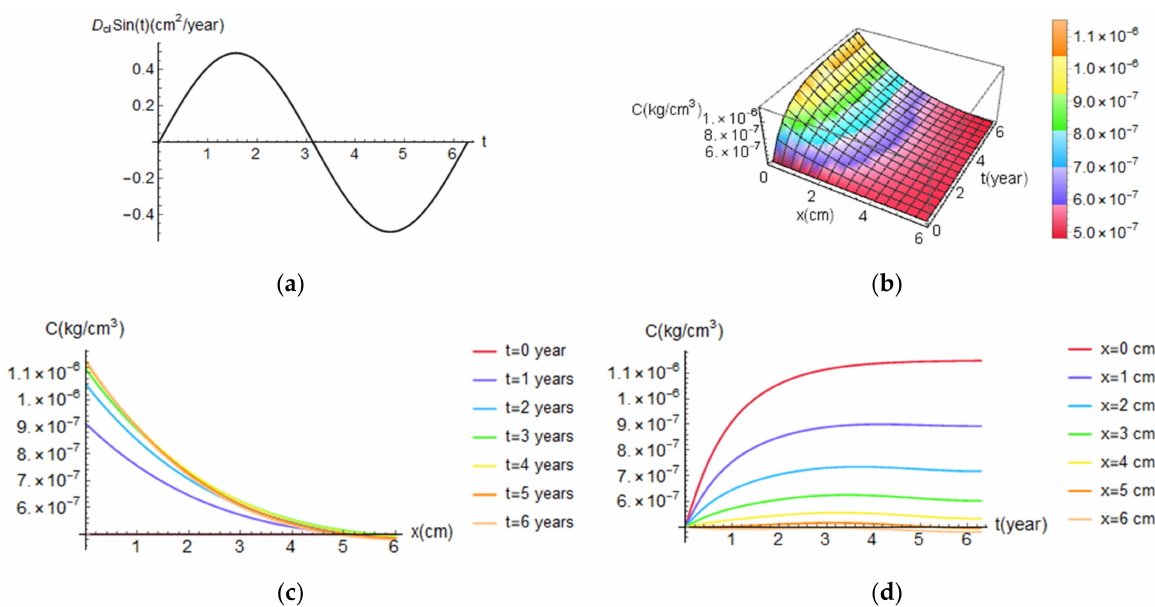
Figure 6. Numerical results for sinusoidal f D (x,t): ( a ) its trend; ( b ) 2D complete results; ( c ) results in x domain; ( d ) results in t domain.